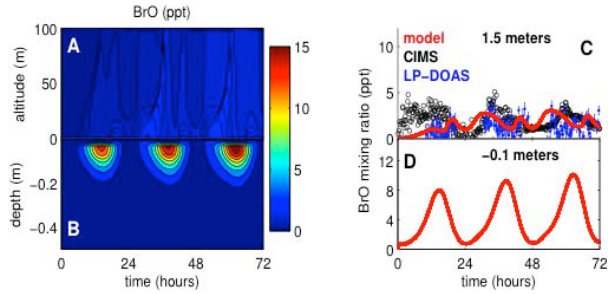
Fig. 10. Model predicted BrO using a 1-D coupled snow- atmosphere model, MISTRA-SNOW, during summer 2008 com- pared to measured BrO mixing ratios above the snow (C) . The model predicts enhanced BrO mixing ratios in the interstitial air ( B, D ) due to snow chemistry. Taken from Thomas et al. (2011) with permission of the